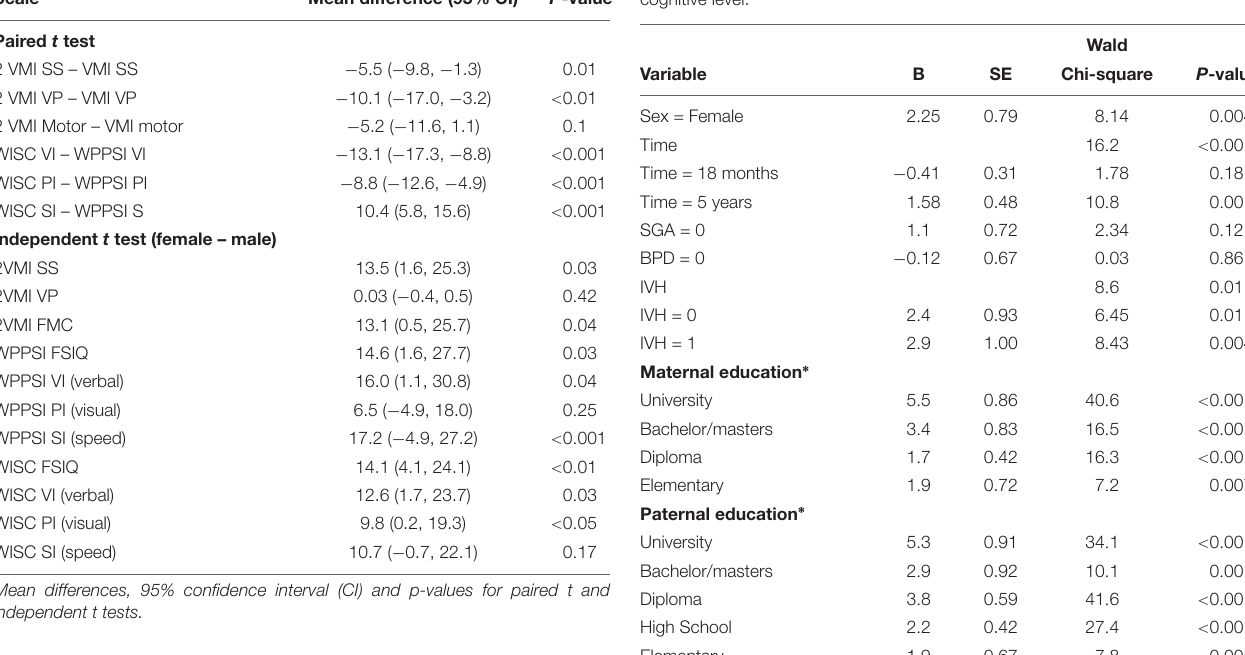
TABLE 5 | Results of GEE univariate analysis with parameter estimates, standard errors and Wald Chi square for the cohort for the dependent variable cognitive level. Variable B SE